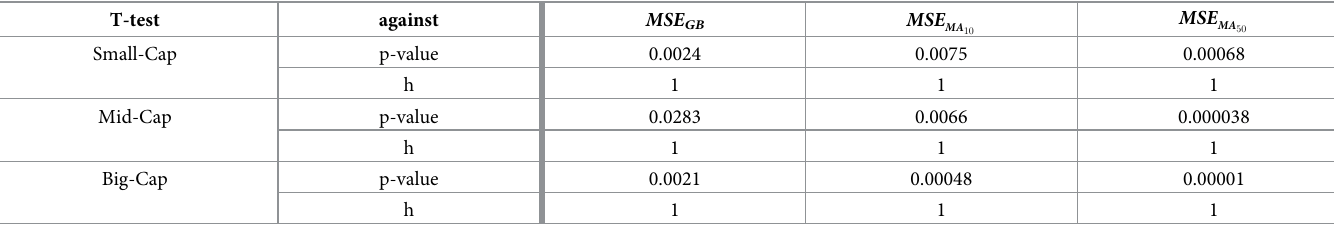
Table 2. Statistical analysis for MSE values for stocks in different market cap categories ( M = 350).